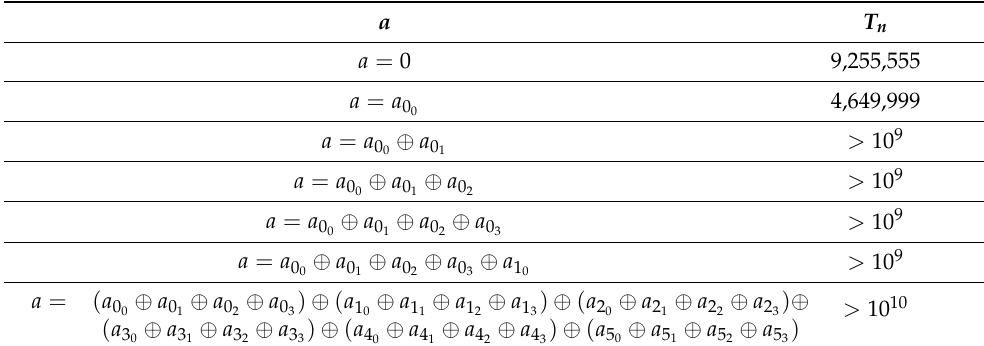
Table 2. Dependence of T n on the output signal a of a logical scheme LS ( q = 6 )